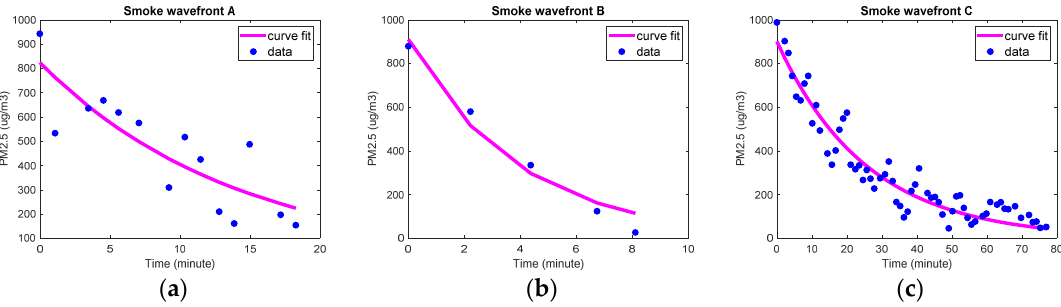
Figure 6. ( a ) Curve fitting of decay profile of PM 2.5 concentration during the smoke wavefront A (shown in the time-series plot of Figure 5); ( b ) cure fitting for smoke waveform B; ( c ) curve fitting for smoke waveform C. Time in x-axis is measured from the peak intensity of smoke-waves. Table 2. Smoke wavefront decay half-life. Curve